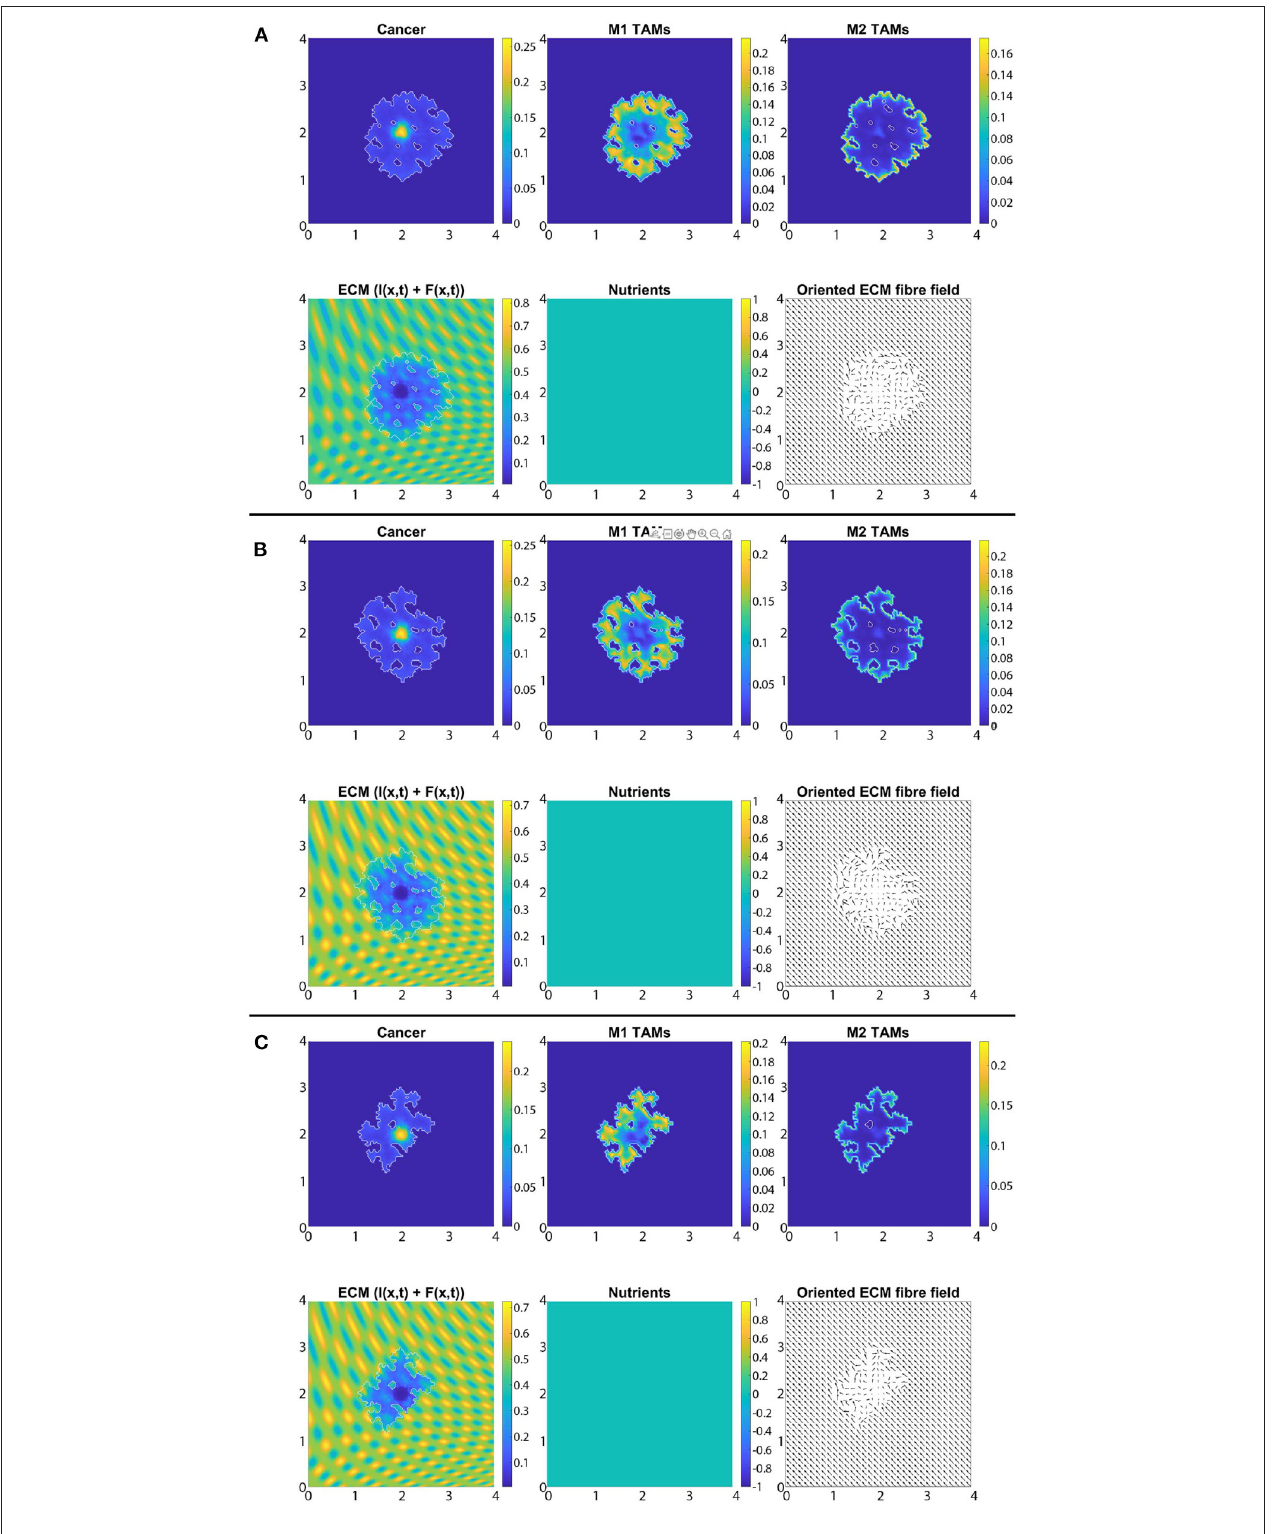
FIGURE 12 | Simulation with re-polarisation domain (cid:127) p ( t , 1 x ), starting time t p = 0 and with no nutrients (i.e., σ ( x , t ) ≡ 0, ∀ ( x , t ) ∈ Y × [0, T ] and 9 p ( σ ) ≡ 1, 9 dc ( σ ) ≡ 1, 9 dM ( σ ) ≡ 1 and 9 M ( σ ) ≡ 1, ∀ σ and S M σ = 0) at the final time 50 1 t . (A) β = 0.75, (B) β = 0.7875, and (C) β =